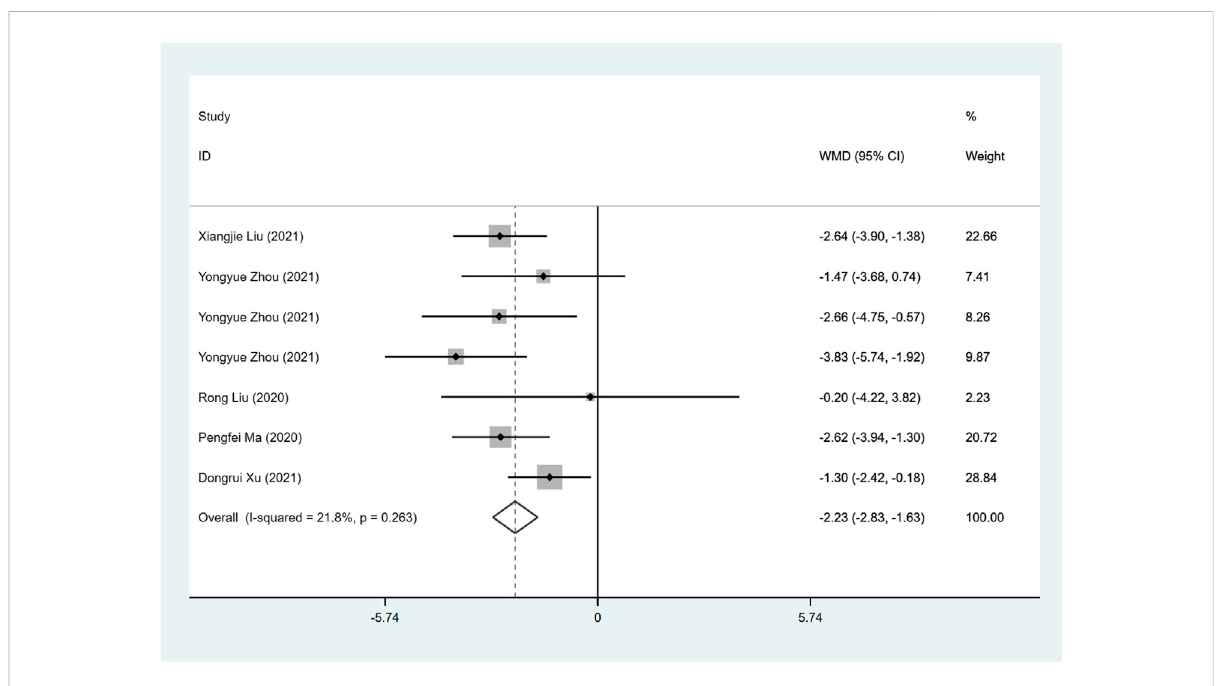
FIGURE 4 Forest plot of LAD between sacubitril-valsartan and ACEI or ARB.